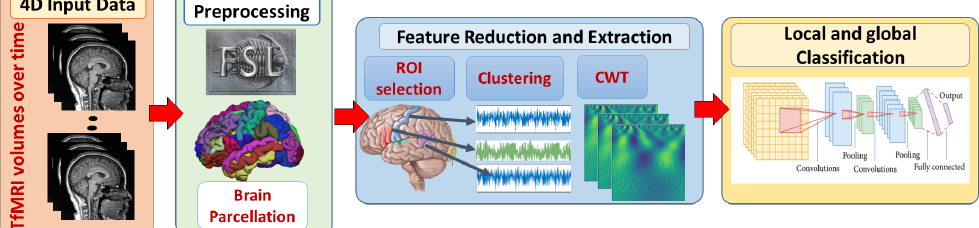
Figure 1. The proposed framework for local and global classification. First, 4D fMRI data are preprocessed with FSL. Brain extraction and parcellation to Harvard-Oxford probabilistic atlas are also performed. Second, spacial and temporal feature reduction and extraction techniques are performed. Finally, local classification models on each ROI are developed to provide a global classification